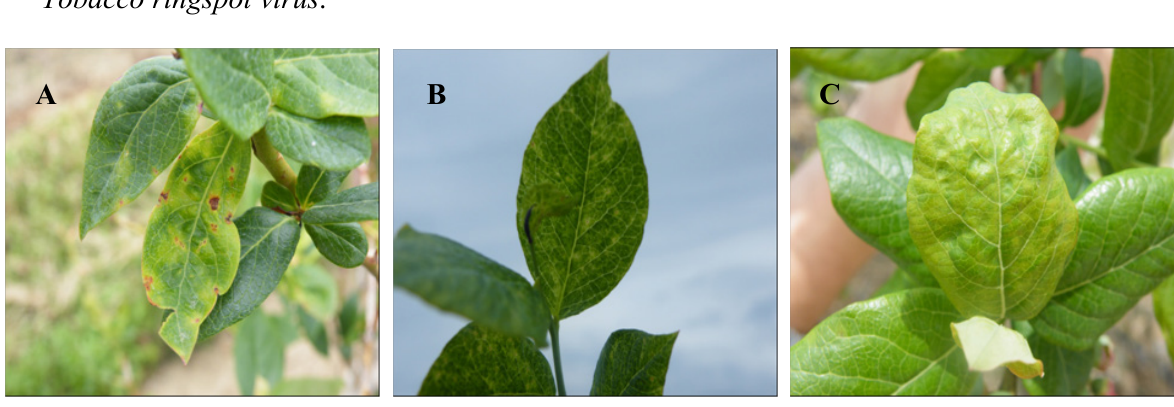
Figure 2. Symptoms of necrotic ringspot disease in blueberry: ( A ) Tomato ringspot virus in blueberry showing necrotic spots and leaf distortion; ( B ) Chlorotic mosaic symptoms on plant infected with ToRSV; and ( C ) Mosaic on young leaves of plant infected with Tobacco ringspot virus